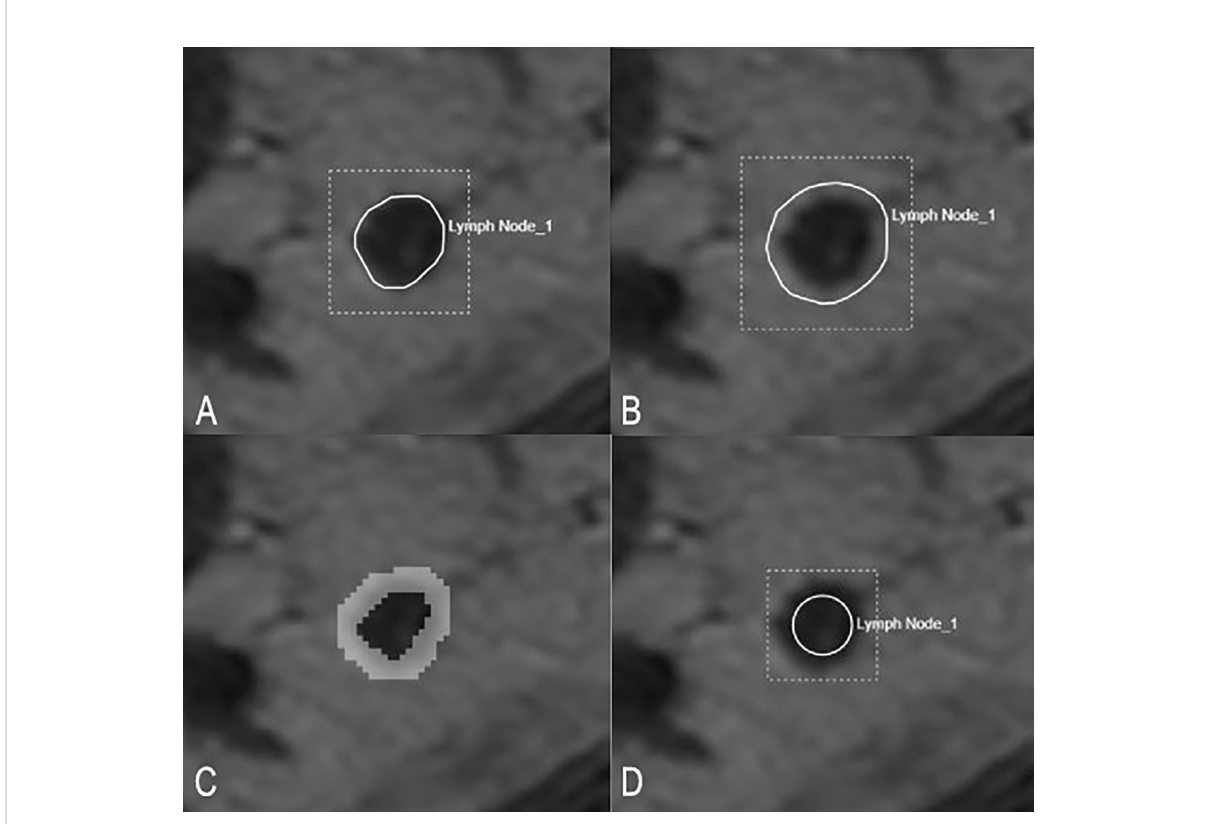
FIGURE 3 Schematic diagram of four segmentation methods. (A) shows the ROI along the border of LN. (B) shows the ROI along the border of LNs and expand outward by 2 – 3 mm. (C) shows the ROI only covering the edge of LNs. (D) shows the ROI as a circle located inside an